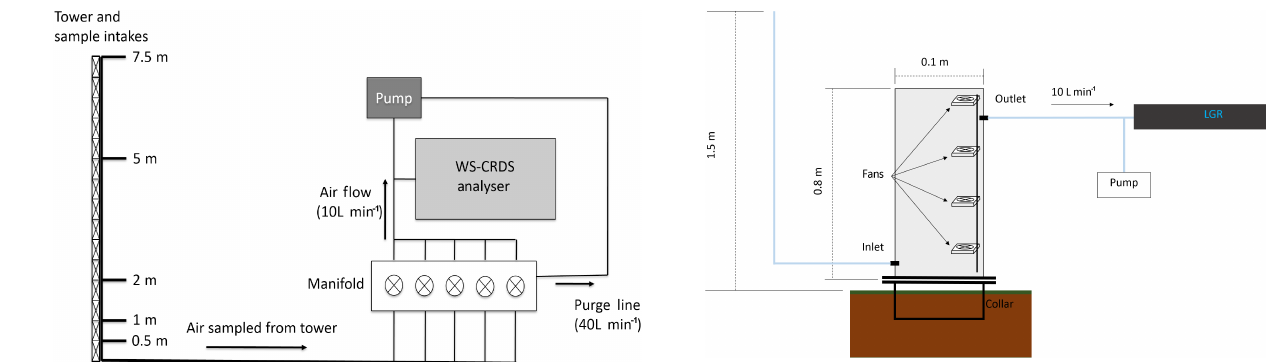
Figure 2. Sampling system for the automated in situ collection and measurement of water vapour isotopes from the tower.